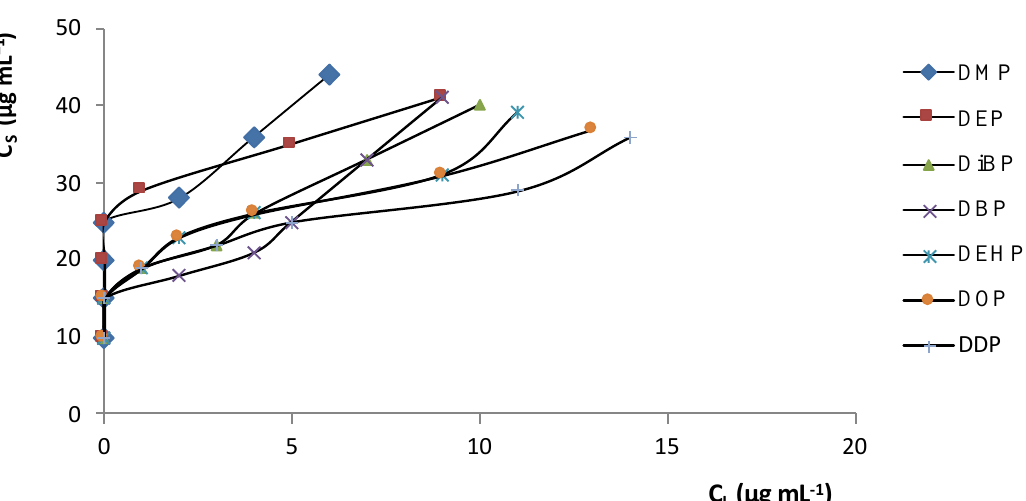
Figure 2. Distribution isotherms of PAEs between C 18 adsorbent and the water solution at 25 °C.